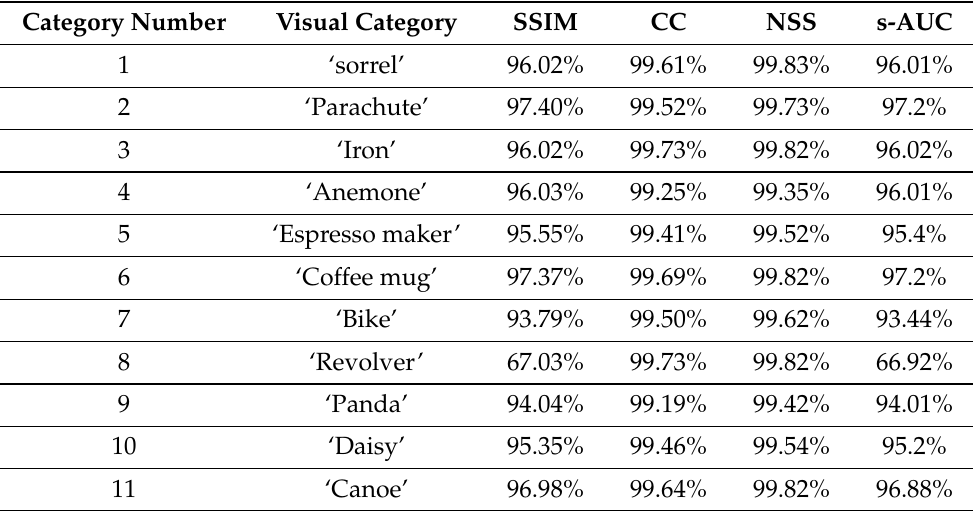
Figure 14. Confusion matrix for classification of test splits in 10-fold cross-validation technique with GDN part of the proposed GDN-GAN. Table 6. SSIM, CC, NSS, and s-AUC of the proposed GDN-GAN for each